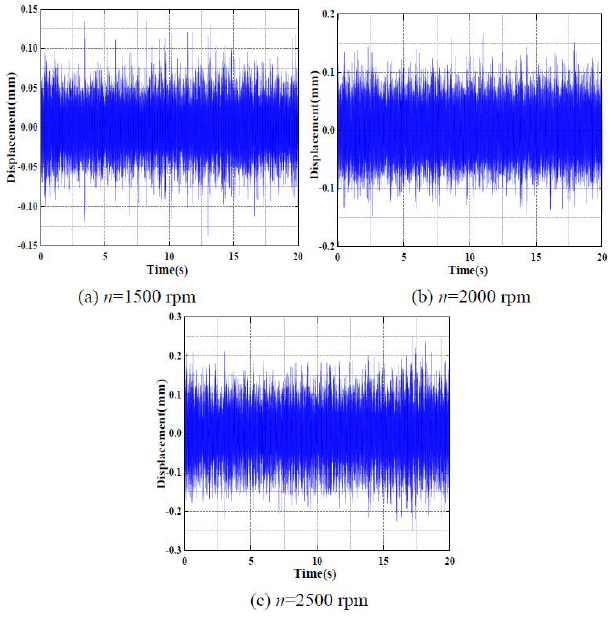
Figure 14. Time domain vibration displacement signals of the gear- box at different speeds.